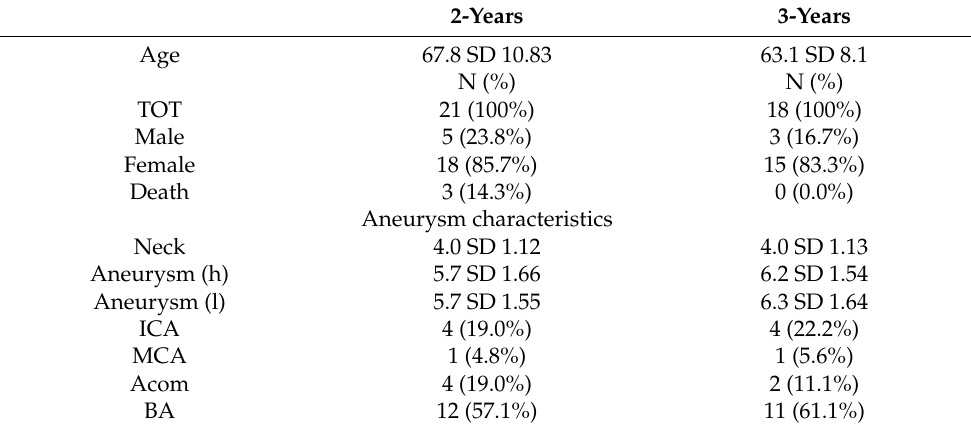
Table 2. Aneurysm occlusion degree in relation to its position at 2-year